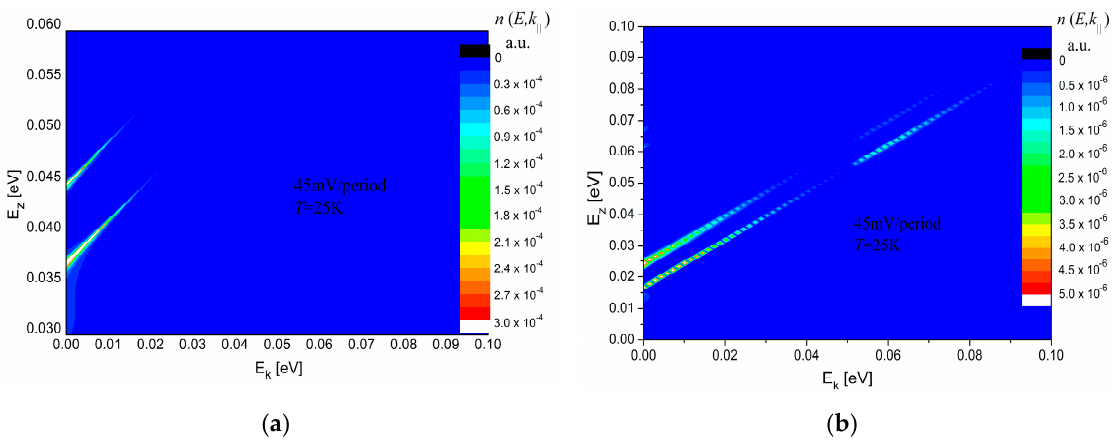
): ( a ) for the fixed electron ||